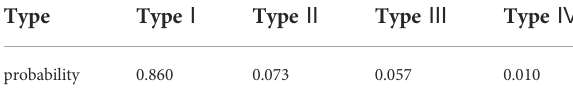
TABLE 6 Types of spatial and temporal leaps in net carbon